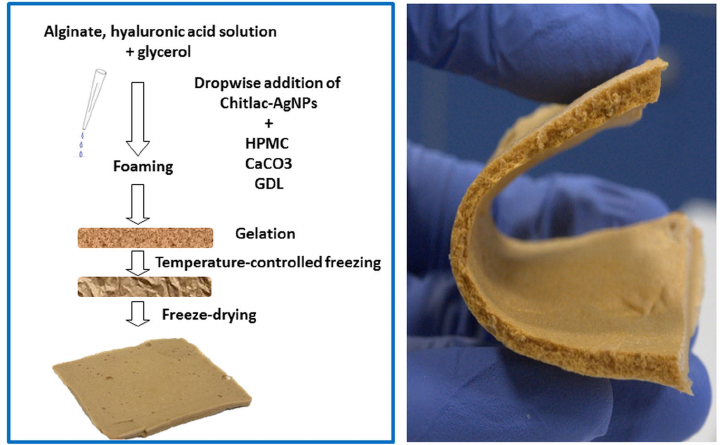
Figure 8. Sketch of the procedure to obtain foamed membranes containing Chitlac–AgNP ( left ) and an image of a membrane with cut edge where the internal spongy structure and the flexibility of the material can be observed ( right ). Reprinted with permission from [139].